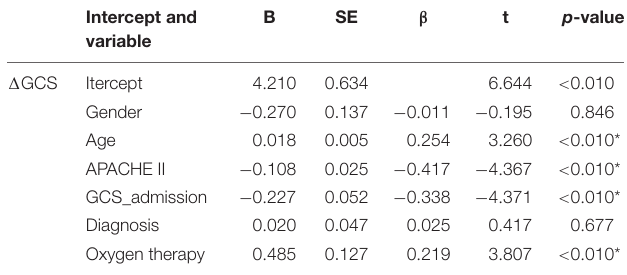
TABLE 2 | Outcome of respiratory complications, short term neurological prognosis, and general outcomes.